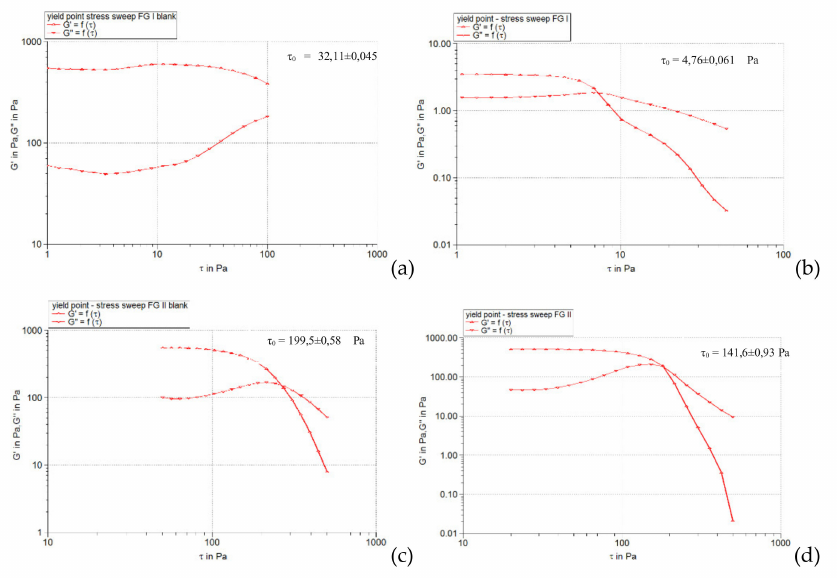
Figure 8. G’ and G” modulus curves as a function of stress at 1 Hz for Carbopol 940 and glycerol- based hydrogels, simple or loaded with caffeic acid liposomes: ( a ) FGI blank, ( b ) FGI, ( c ) FGII blank, ( d )